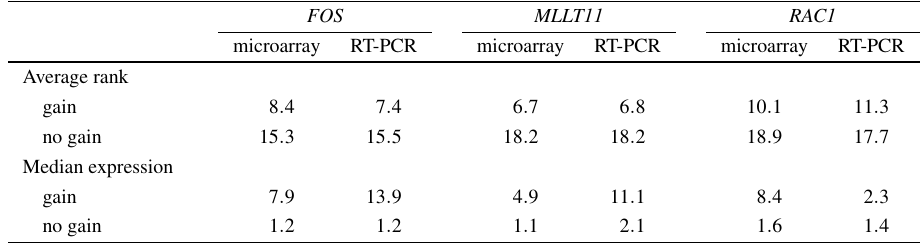
Validation of FOS , MLLT11 , and RAC1 as over-expressed genes in samples with array-CGH gain. The rank values indicate the sort order of the samples based on the expression values (lowest rank numbers for samples with high- est expression). Expression values from both real-time RT-PCR and oligo microarray analyses are relative to the expression level in normal testis